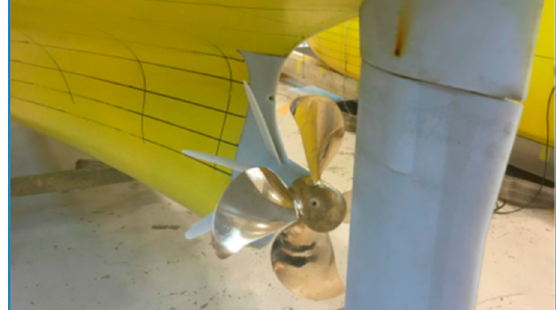
Figure 17. Propulsion test setup with the designed PSS.